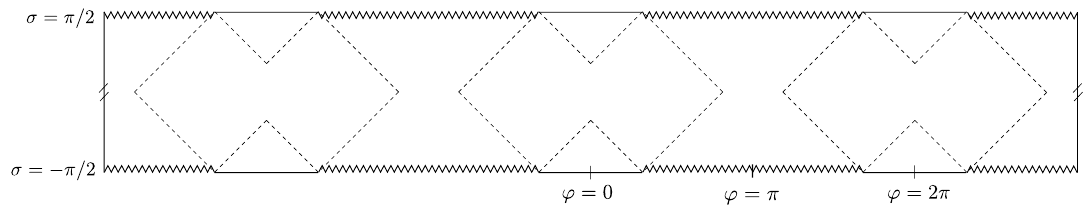
Figure 1. Solution to JT gravity with n = 3 . The magnitude of the Casimir energy due to matter decreases as n increases, leading to crunching regions which are larger than inflating regions. The Penrose diagram is periodically identified, making the spatial topology that of a